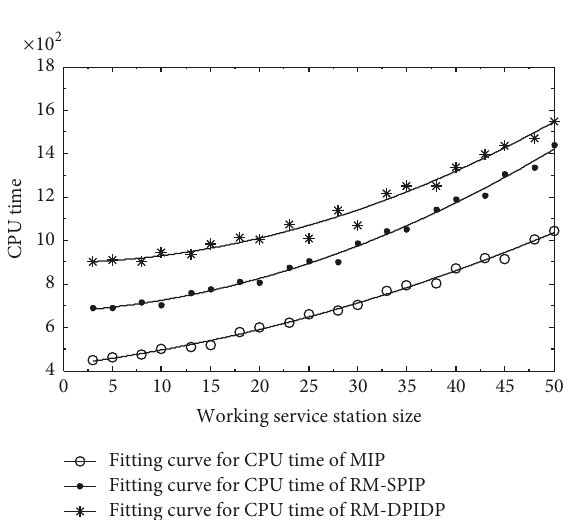
Fitting curve for CPU time of MIP Fitting curve for CPU time of RM-SPIP Fitting curve for CPU time of RM-DPIDP Figure 8: Fitting curve of CUP time for 3